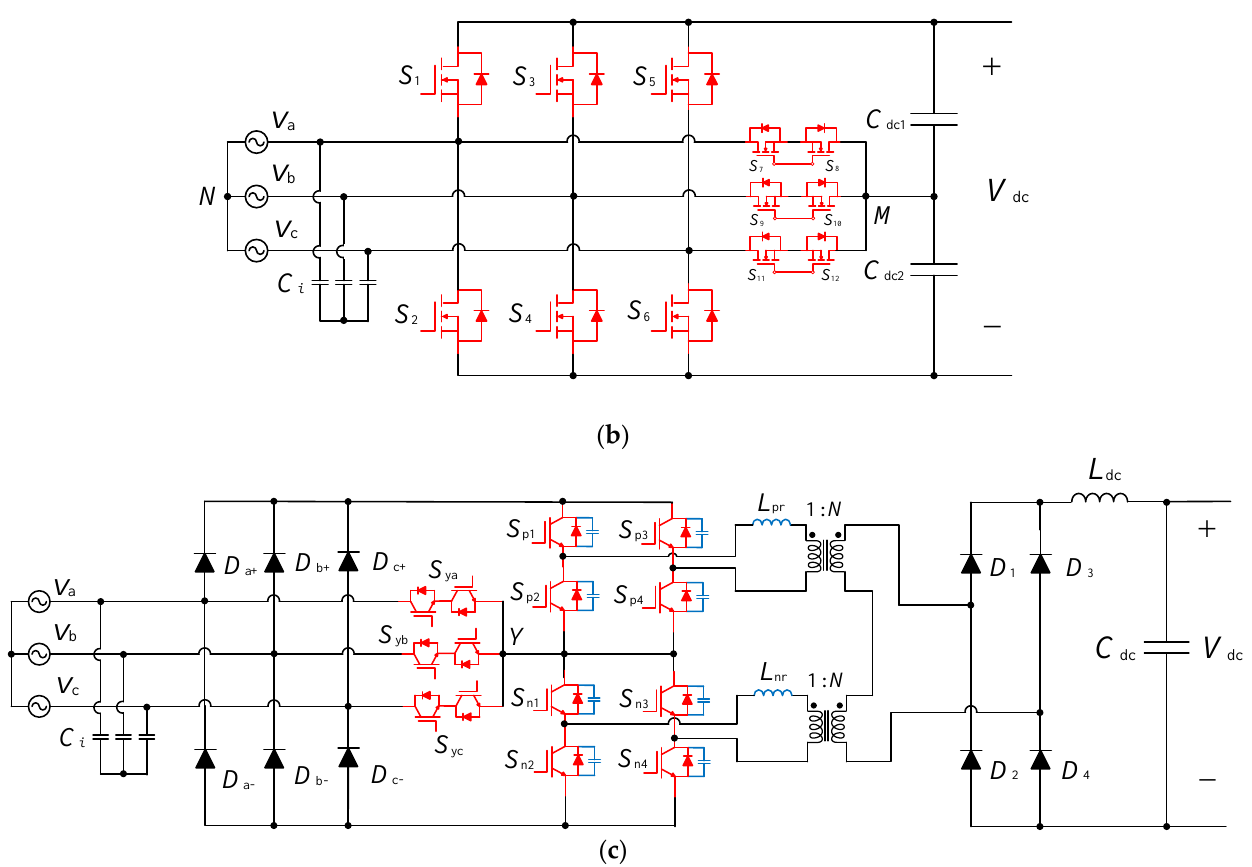
Figure 11. Grid-interfaced topologies: ( a ) Three-phase modified Buck type converter, ( c ) VIENNA converter, and ( c ) SWISS converter. Table 4. A technical comparison among grid-interfaced converter topologies.